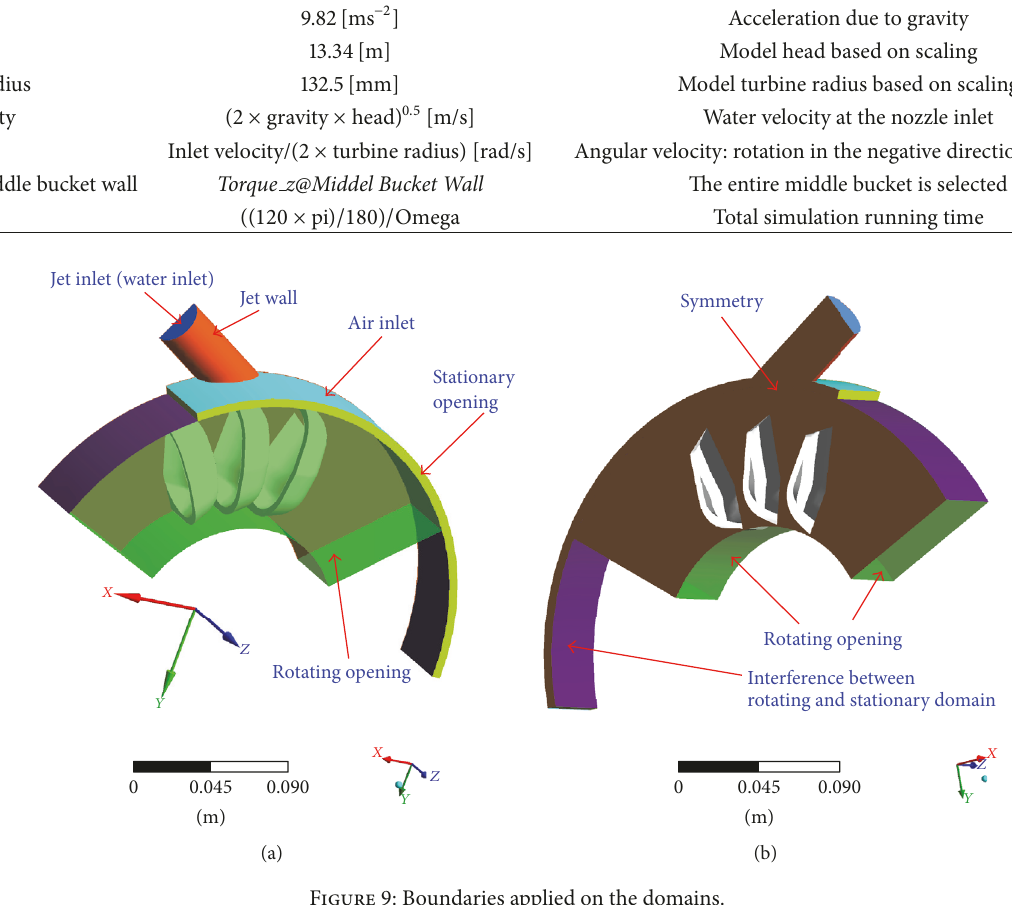
Figure 9: Boundaries applied on the